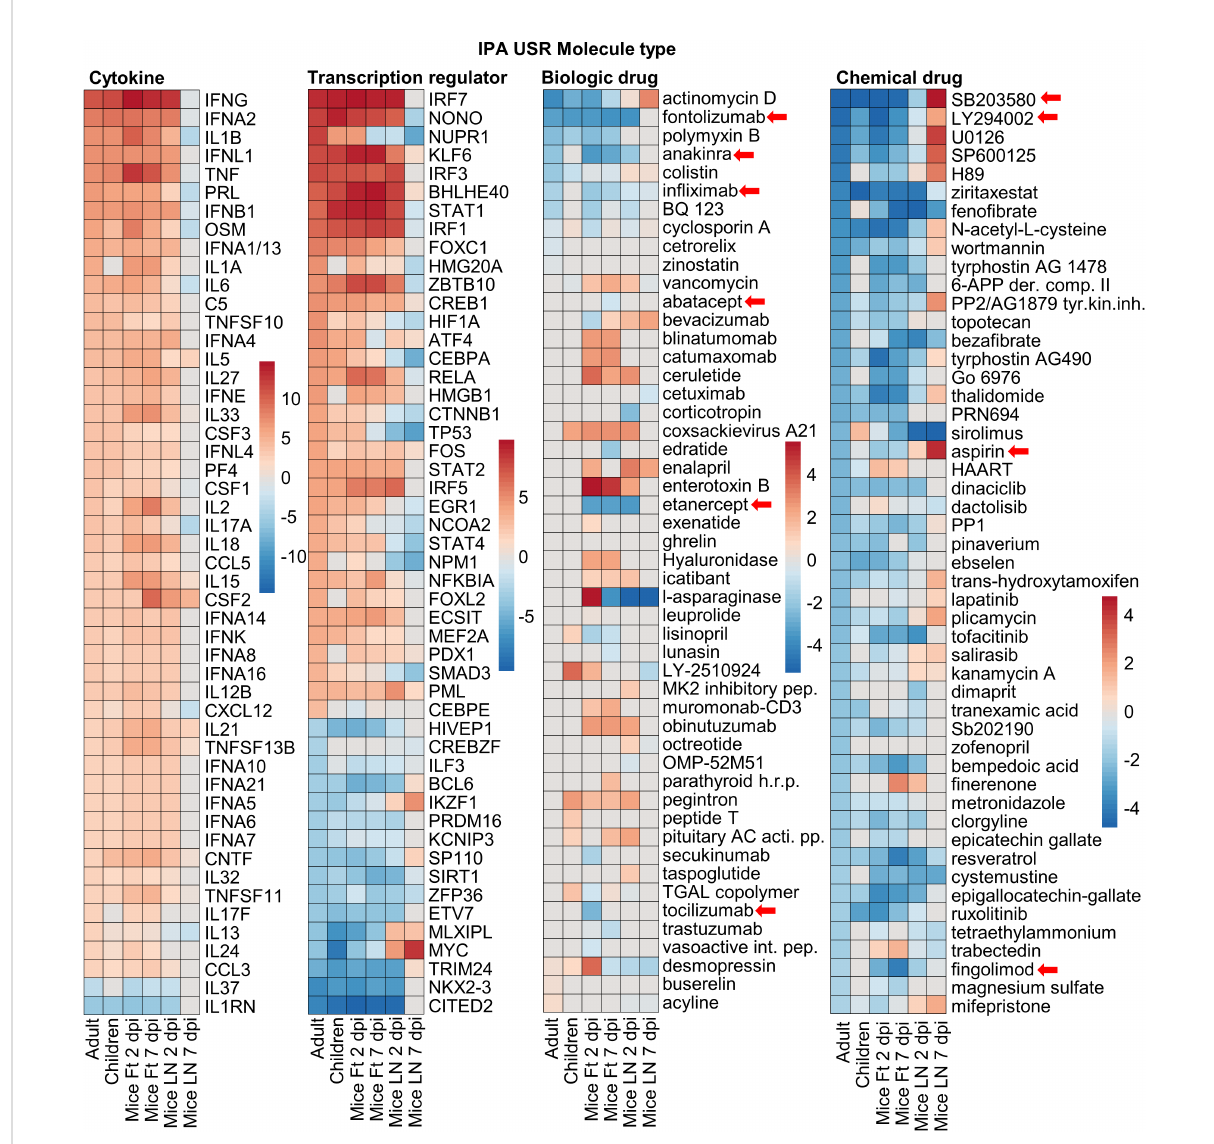
FIGURE 4 IPA USRs heatmaps. The DEG lists for all groups were analyses by IPA and the top 50 USRs (signi fi cant in at least 1 group) plotted by molecule type and ranked by USR z-scores for Adults. Cytokine and Transcription regulator – USRs for Adults ranked by absolute z-score. Biologic and Chemical drug – ranked from highest negative z-score (most potent predicted inhibitor). Red arrows indicates compounds referred to in the text. Abbreviations: AC acti. pp - adenylate cyclase-activating polypeptide; intest. pep. intestinal peptide; APP der. comp. II - 6- aminopyrazolopyrimidine derivative compound II; h.r.p.- hormone related protein; HAART - highly active antiretroviral therapy; tyr.kin.inh. tyrosine kinase